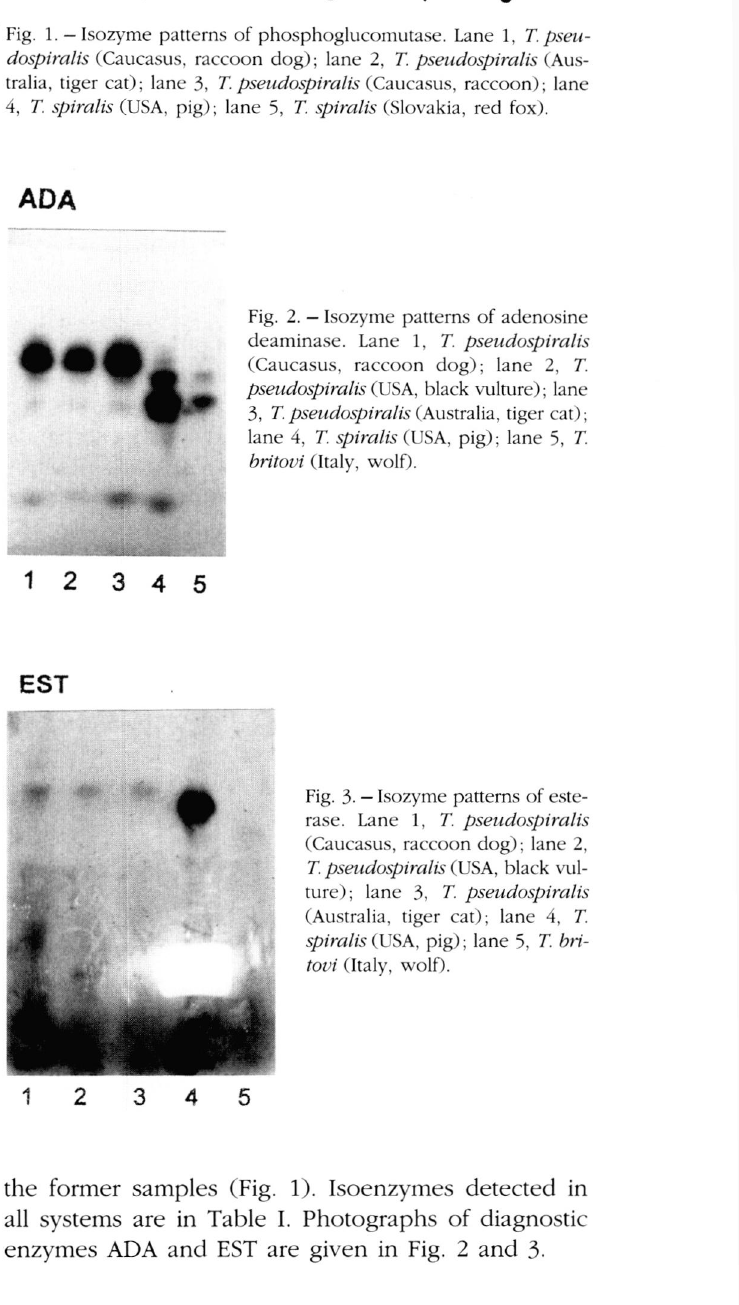
Fig. 1. - Isozyme patterns of phosphoglucomutase. Lane 1, T. pseu- dospiralis (Caucasus, raccoon dog); lane 2, T. pseudospiralis (Aus tralia, tiger cat); lane 3, T. pseudospimlis (Caucasus, raccoon); lane 4, T. spiralis (USA, pig); lane 5, T. spiralis (Slovakia, red fox).